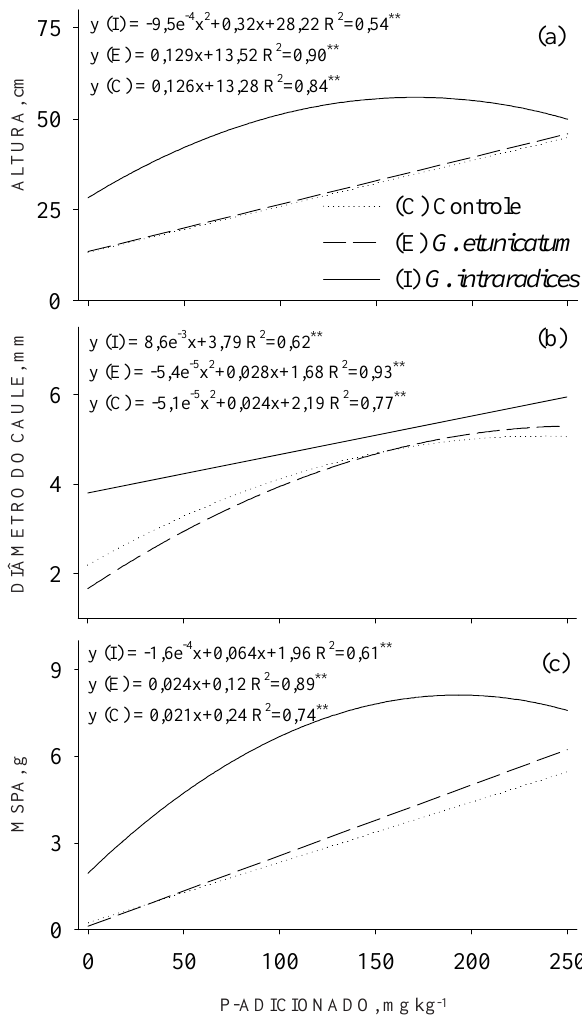
Figura 1. Altura (a), diâmetro do caule (b) e matéria seca da parte aérea (c) de plantas inoculadas com G. etunicatum , G. intraradices ou controle sem FMA, considerando as doses de P. * e ** significativos a 5 e 1%,